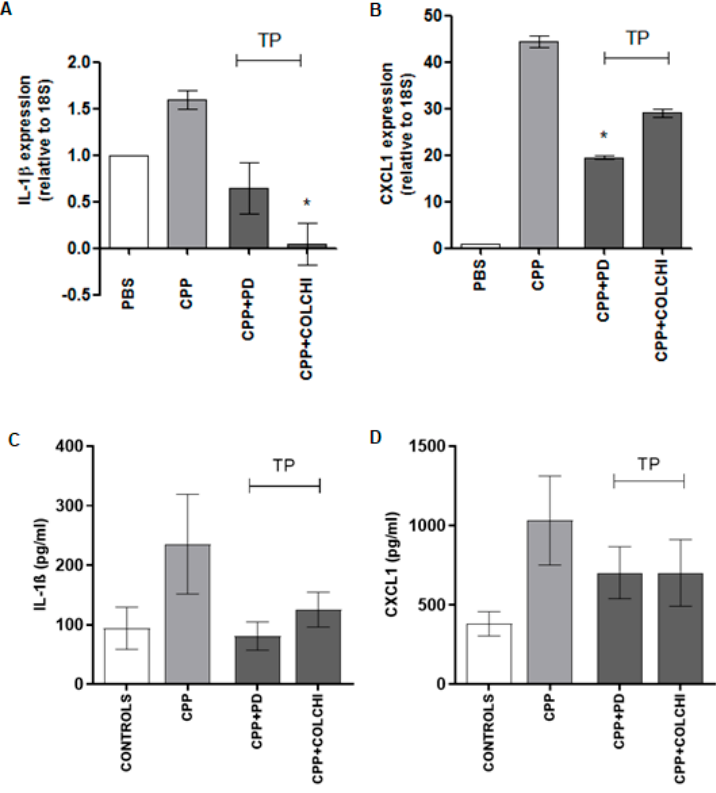
Figure 7. Variation in IL-1 β and CXCL1 mRNA tissue levels ( A , B ) and serum levels ( C , D ) after CPP crystal injection in the therapeutic (TP) protocol. Mice received an i.a. injection of CPP crystals (0.3 mg/20 μ L) and were treated with PD (40 mg/kg) or colchicine (1 g/kg) according to the group allocation (n = 8/group). Tissues were immediately stored in RNA-stabilizing reagent after sacrifice. * p < 0.05 vs. CPP. Cytokines were measured in blood collected by intracardiac puncture and after centrifugation. * p < 0.05 vs. CPP.